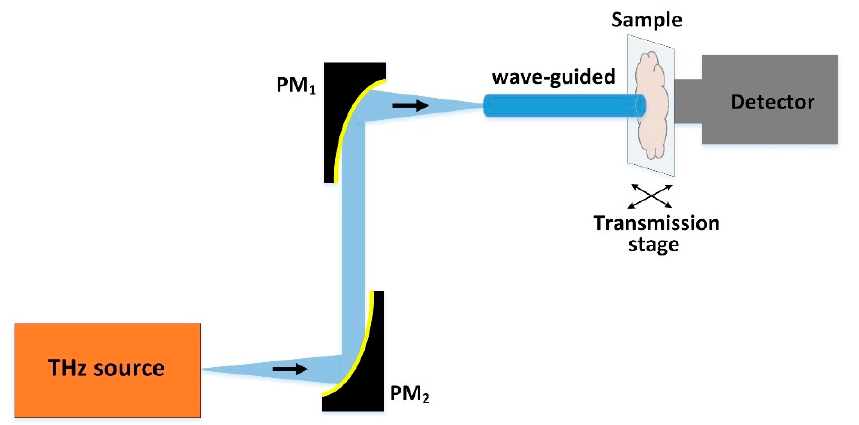
Figure 6. Configuration of the CW-THz near-field imaging system based on THz